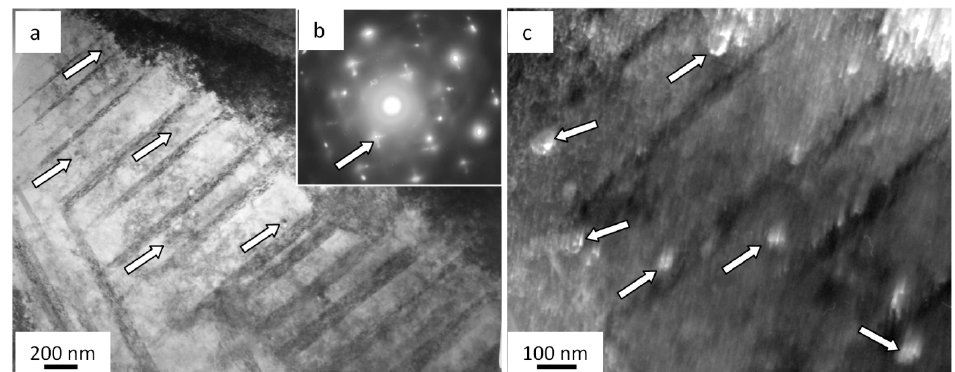
Figure 9. Electron microscopic image of carbide phase particles surrounded by grains in the AISI 310S steel surface processed with electron beams and fractured when fatigue testing; ( a ) bright field; ( b ) electron diffraction micropattern, a reflex where a dark field was obtained is indicated with an arrow; ( c ) a dark field obtained in similar reflexes (002) γ -Fe + (006)Cr 23 C 6 ; arrows ( a , c ) point at carbide phase particles.